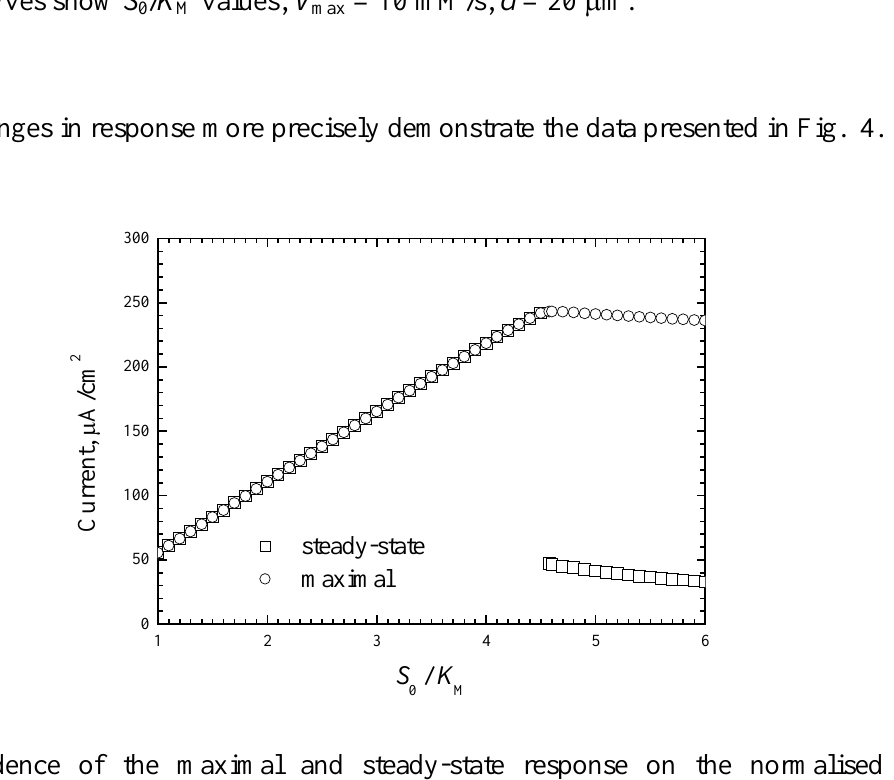
/ K values, V = 10 mM/s, d = 20 µ m. 0 M max